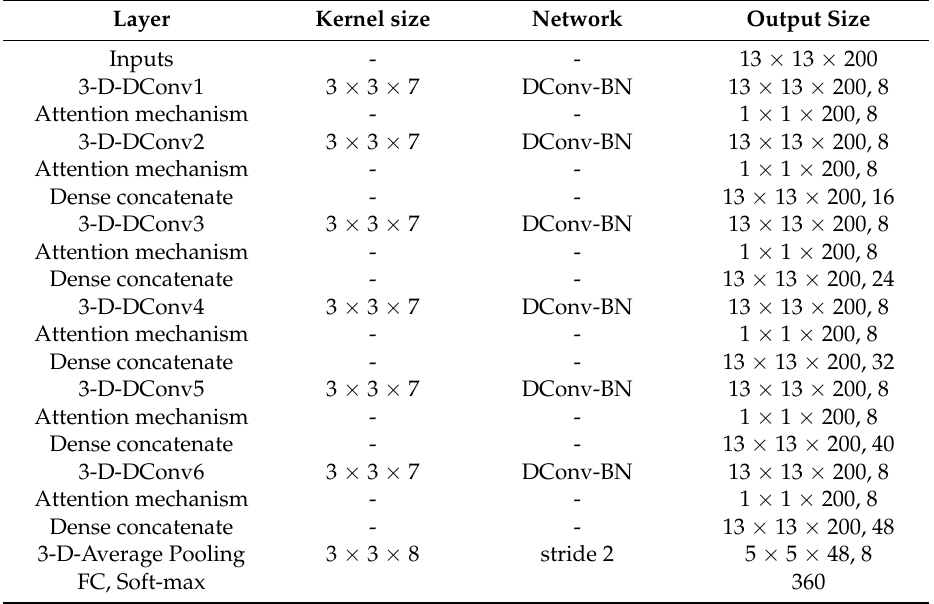
Table 1. Network architecture details of proposed novel end-to-end 3-D dense convolutional network with spectral-wise attention mechanism (MSDN-SA) for Indian Pines Dataset.